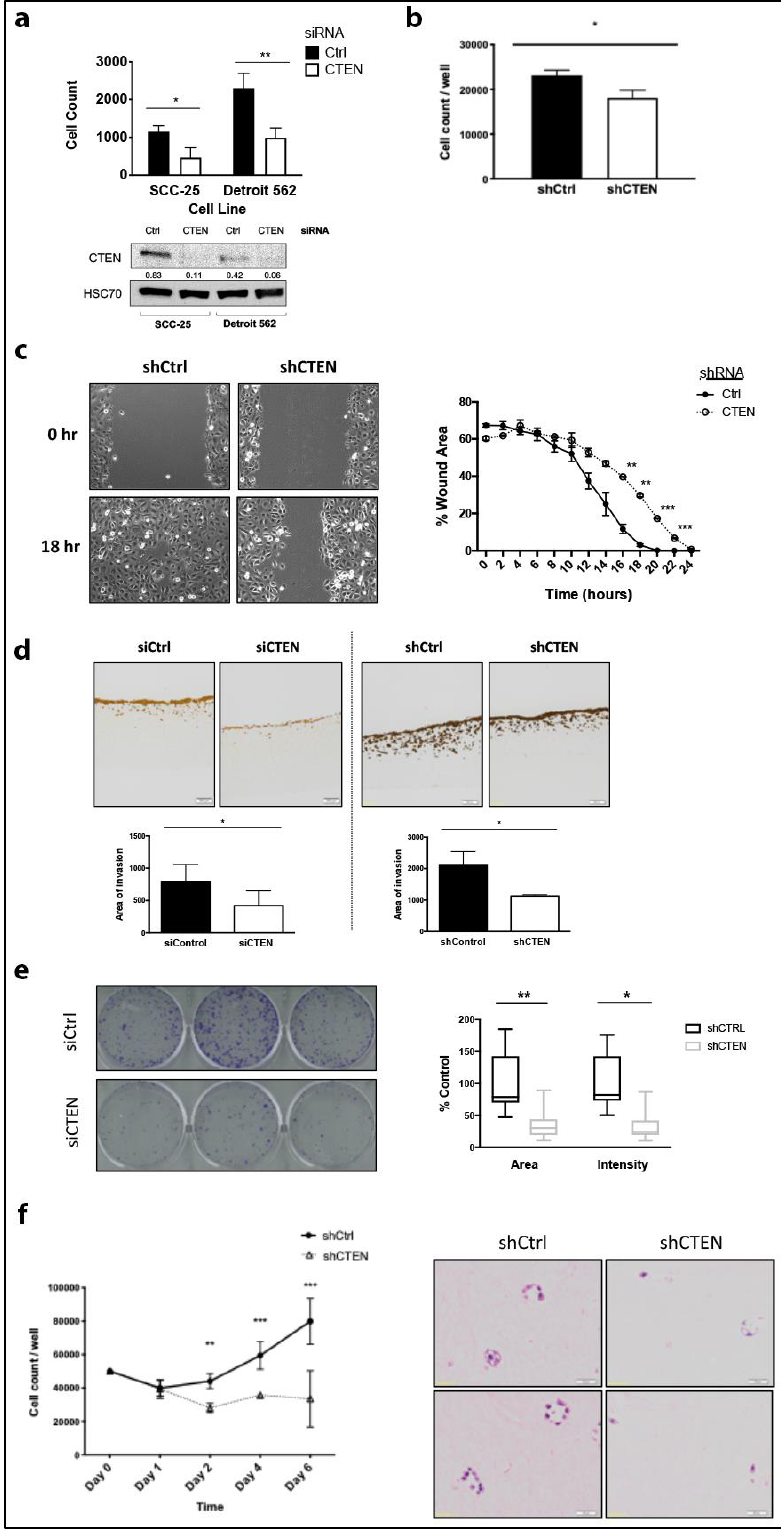
Figure 3. CTEN supports head and neck cancer progression through effects on both invasion and survival. ( a ) Transient CTEN knockdown significantly reduced invasion of SCC-25 (* p < 0.05; Student’s t -test) and Detroit 562 (** p < 0.01) cell lines across a Matrigel TM layer in Transwell inserts towards serum-containing media in the bottom chamber over 72 h. Western blots confirming knockdown are presented underneath corresponding cell lines (lower panel) and HSC70 was used as a loading control. ( b ) Similar e ff ects of reducing cell motility were observed in stable CTEN-knockdown SCC-25 cells (* p < 0.05) in a migration assay performed over 48 h. ( c ) Time-lapse microscopy revealed an